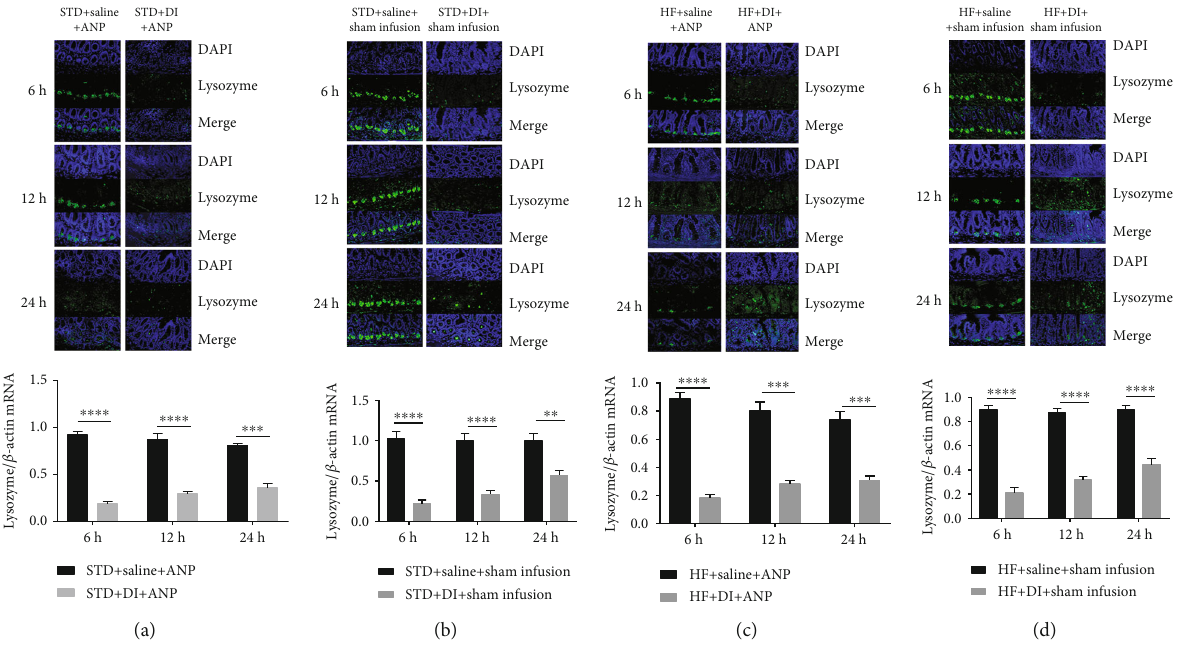
Figure 1: Dithizone depletes lysozyme in ileal crypts in rats. Lysozyme protein expression (green) in Paneth cells of the distal ileum as assessed by immuno fl uorescence. Nuclei were counterstained with DAPI (magni fi cation × 200). Lysozyme mRNA expression as assessed by RT-PCR. (a) STD + saline + ANP vs. STD + DI + ANP. (b) STD + saline + sham infusion vs. STD + DI + sham infusion. (c) HF + saline + ANP vs. HF + DI + ANP. (d) HF + saline + sham infusion vs. HF + DI + sham infusion. ∗ p < 0 : 05 , ∗∗ p < 0 : 01 , ∗∗∗ p < 0 : 001 , ∗∗∗∗ p < 0 : 0001 , Student ’ s t -test. ANP: acute necrotizing pancreatitis; DI: dithizone; HF: high-fat diet; STD: standard diet. Results were expressed as the mean ± SD ( n = 8